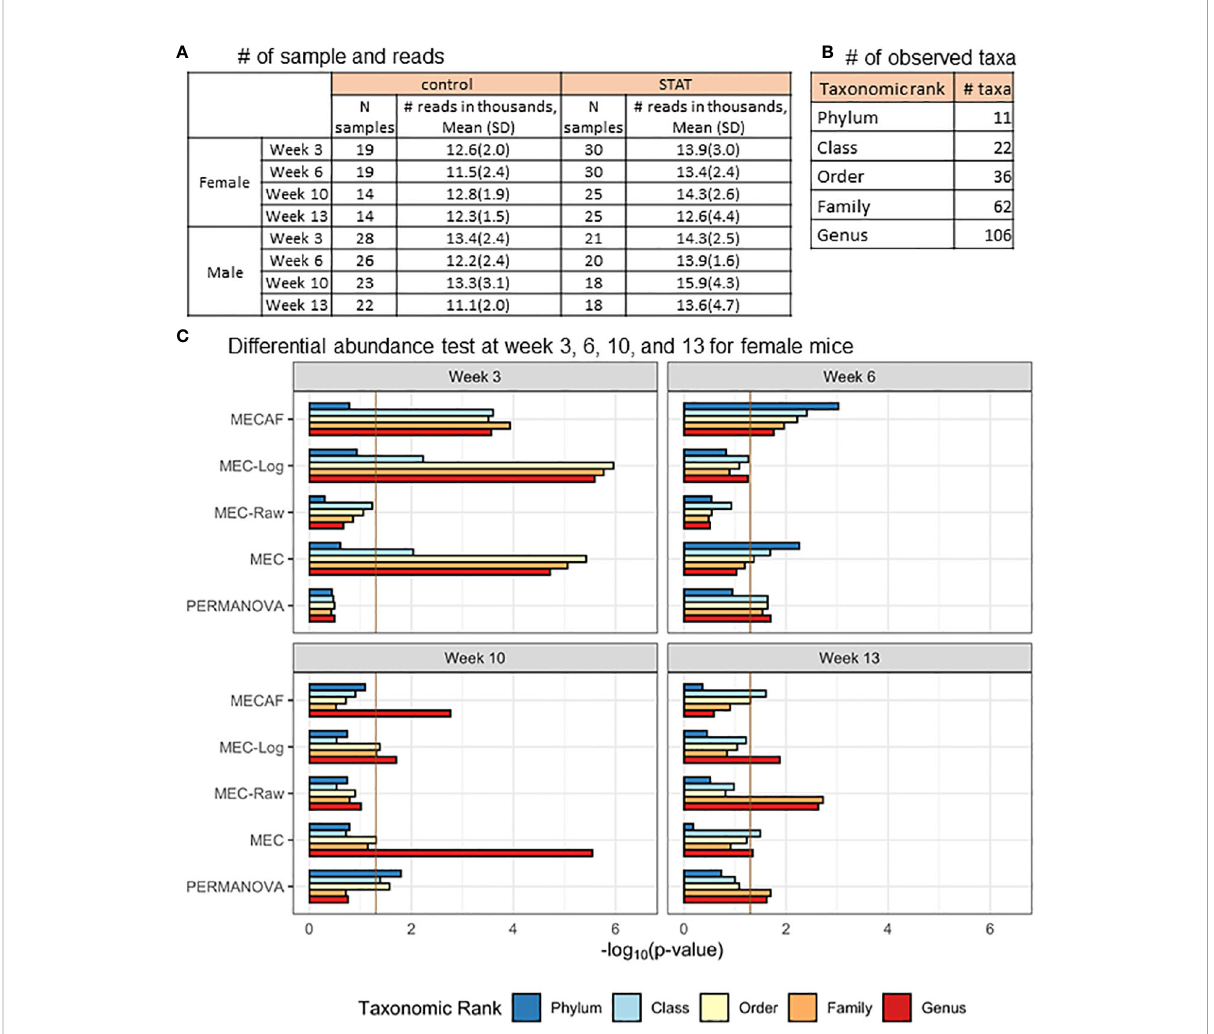
FIGURE 5 DA analysis in female mice of the murine microbiome study. (A) The number of samples and microbial reads are summarized separately for female and male mice. (B) Number of observed taxa at each of the taxonomic ranks. (C) p-Values of DA test with MECAF and competing methods at four assessed time points. p-Values were – log 10 transformed to better illustrate the statistical signi fi cance where the vertical line of -log 10 0.05 indicates the signi fi cance level. DA, differential